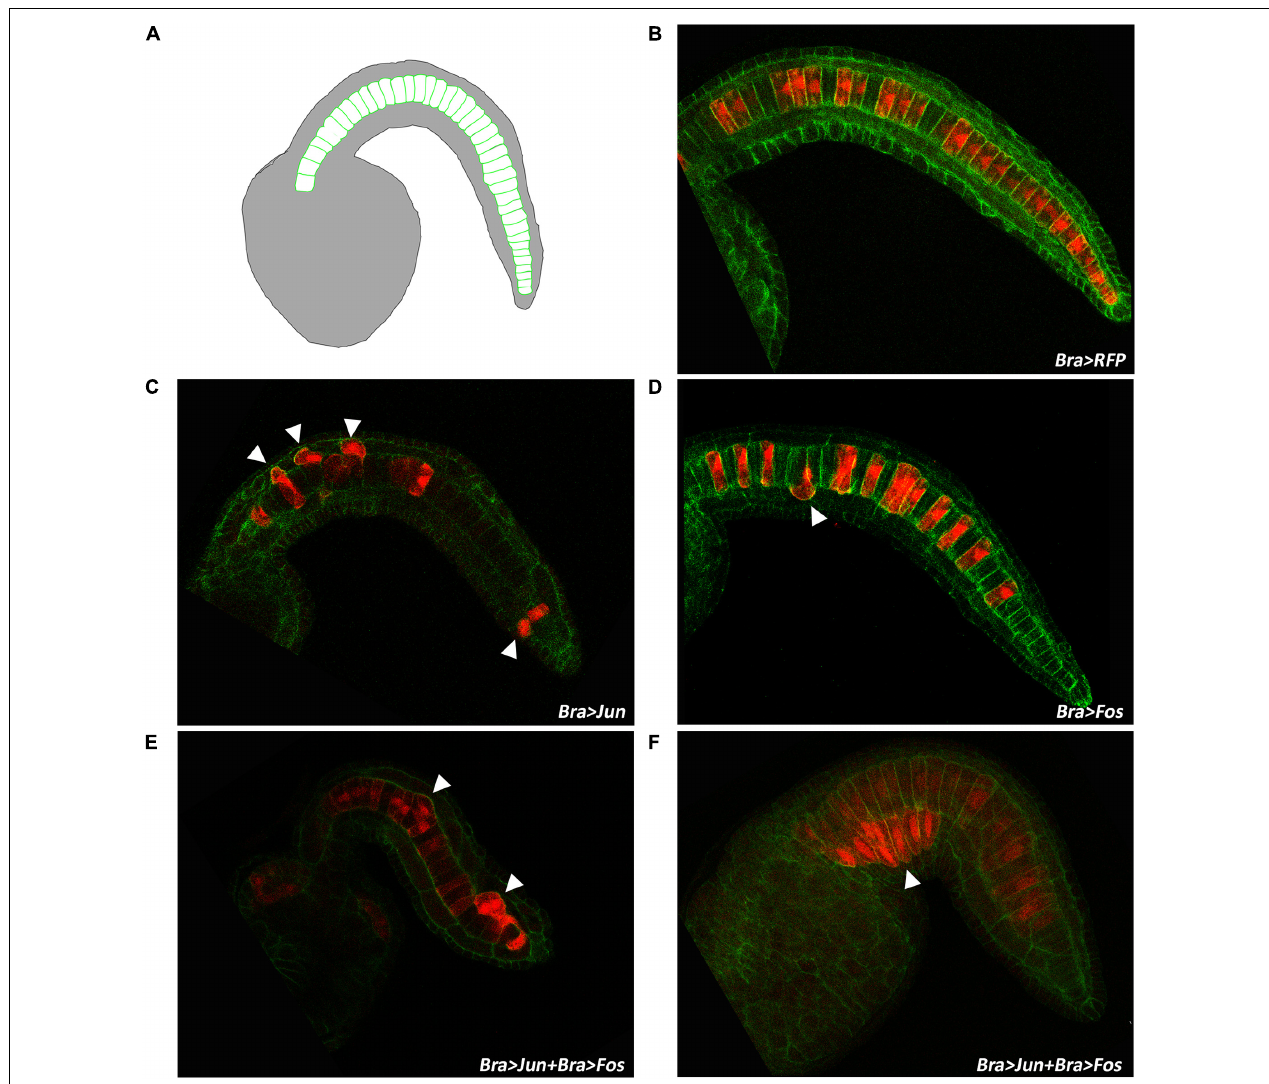
FIGURE 5 | Intercalation defects in tailbud embryos overexpressing Jun and Fos . (A) Schematic representation of notochord cell organization in the late tailbud embryo (stage 23). (B) Confocal microscopy of a stage 23 control embryo electroporated with Bra > RFP. (C,D) Stage 23 embryos co-electroporated with Bra > RFP and either Bra > Jun or Bra > Fos, respectively. (E,F) Embryos at the same stage, co-electroporated with Bra > RFP and Bra > Jun plus Bra > Fos showing altered organization of notochord cells along the tail. White arrowheads evidence misaligned cells. Red, red fluorescent protein (RFP) staining; green, phalloidin